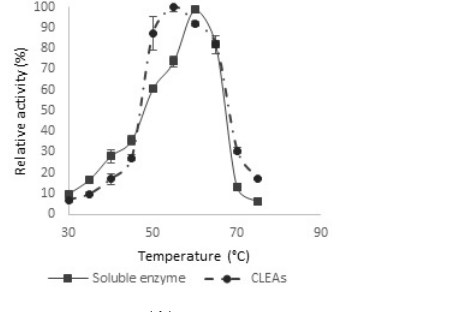
Figure 3. Effect of cross-linking time on β -glucosidase activity immobilized via the CLEAs technique (100% Relative activity corresponds to a hydrolytic activity of 1.48 U/mL).